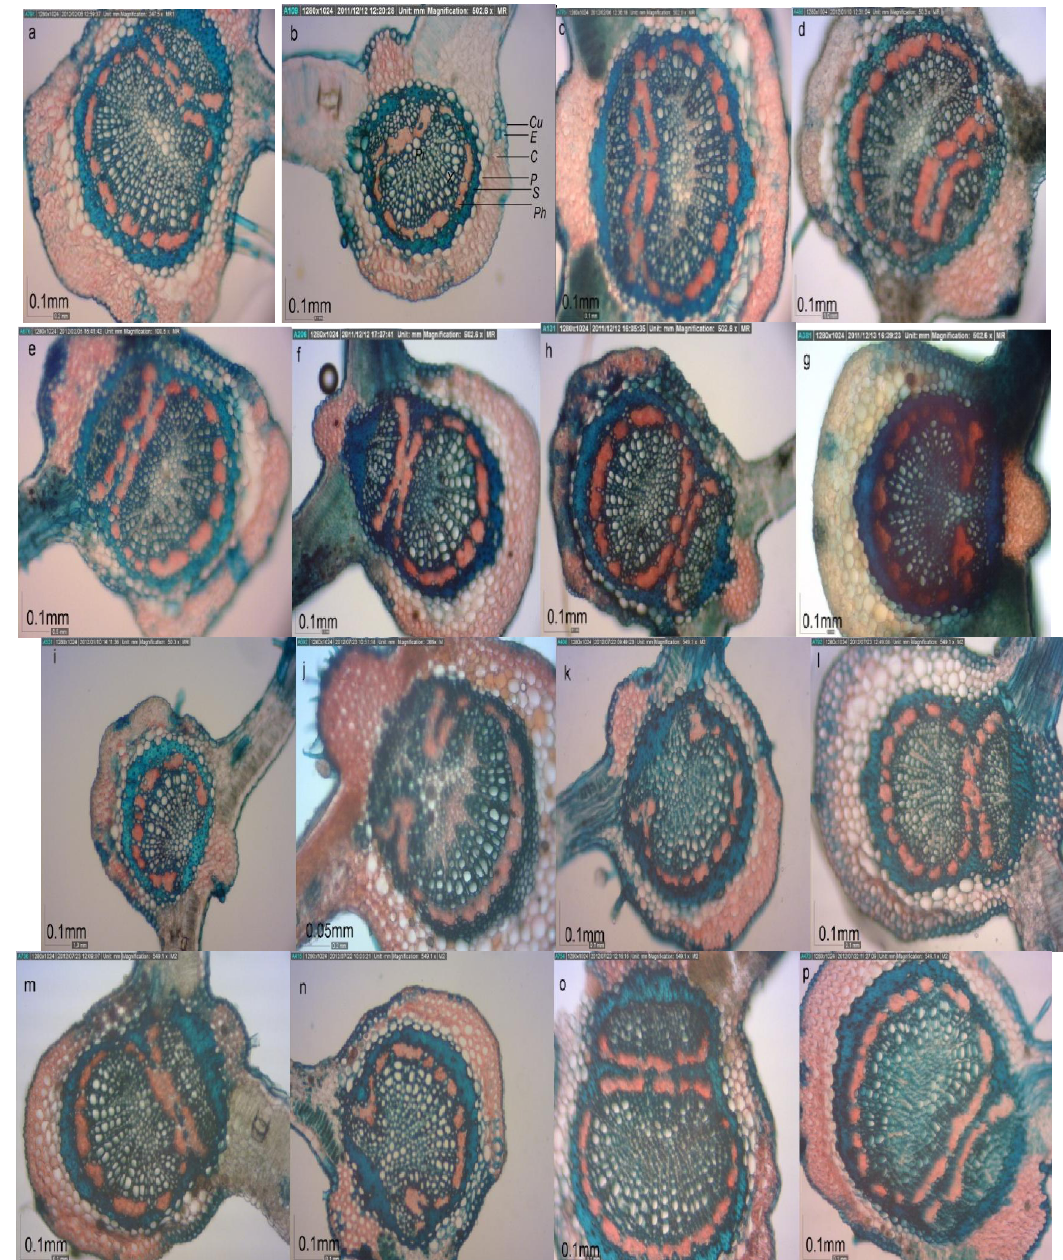
Fig. 3. midrib cross sections (midribs) in the populations of C. orientalis: a, Abshar; b, Gheji; c, Kanigandi; d, Kiasar (1000 m a.s.l); e,Kiasar (1400 m a.s.l); f, Rasht (1600 m a.s.l); g, Rasht (1800 m a.s.l); h, Tangeh Gol; I, Tangrah; j, Qozlogh (1100 m a.s.l); k, Qozlogh (1300 m a.s.l); l, Zaringol; m, Mohammad Abad; n, Parand (904 m a.s.l); O, Parand (805 m a.s.l); P, Chelav. Cu – cuticle; E – epidermis; P – parenchyma; C – collenchymas; S – sclerenchyma; PH – phloem; X-